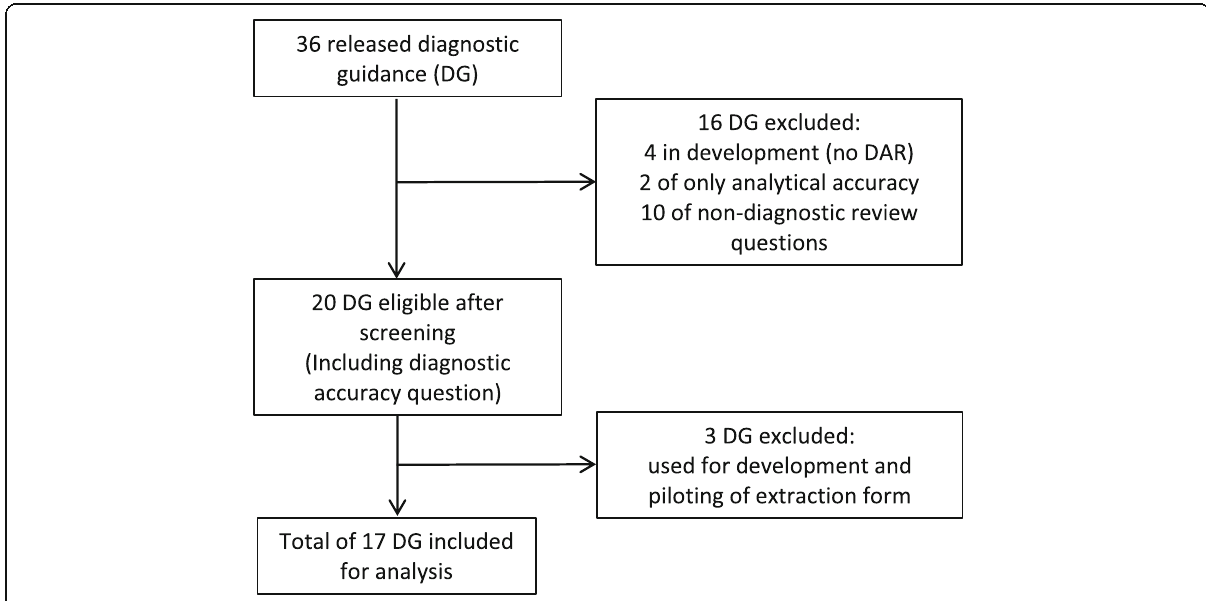
Fig. 1 Flow diagram of the diagnostic